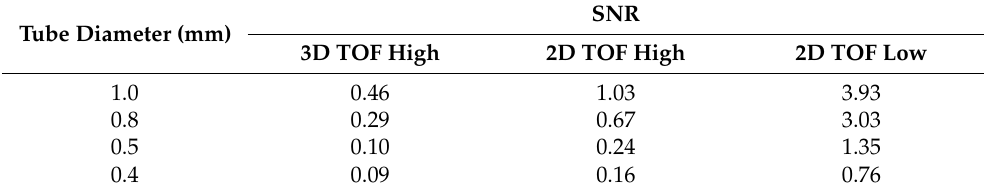
Table 4. SNRs of each TOF sequence at different tube diameters.